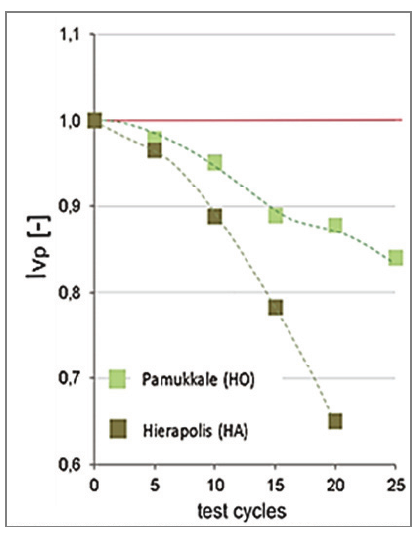
Fig. 4. Ultrasonic waves index I Vp after the impact of frost